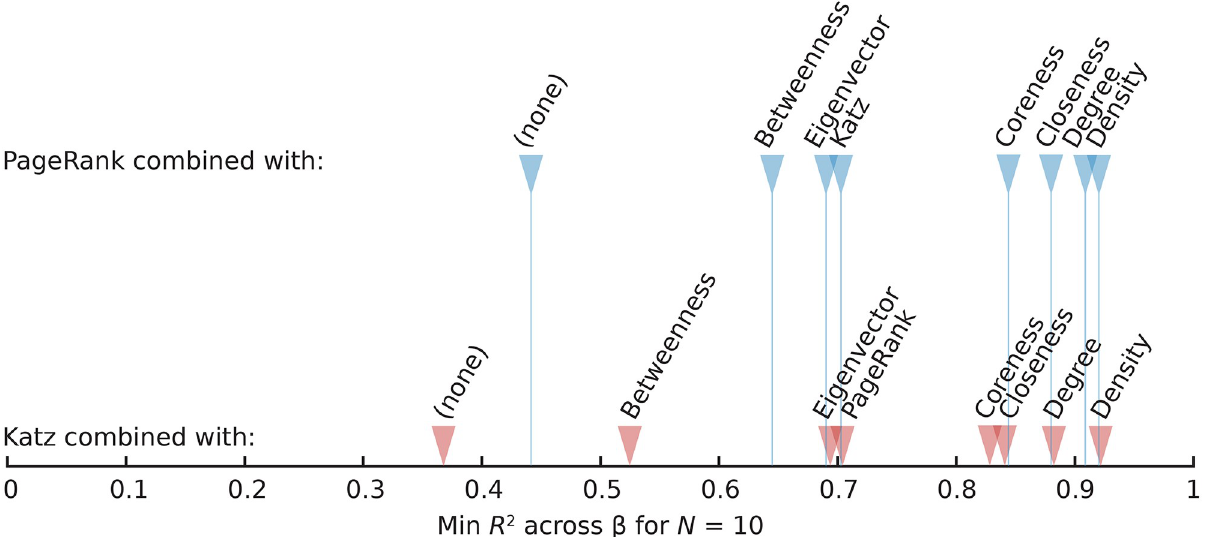
Fig 10. Combinations between PageRank or Katz centrality and other measures. The leftmost markers represent single-feature predictions; the rest are combinations with other measures.